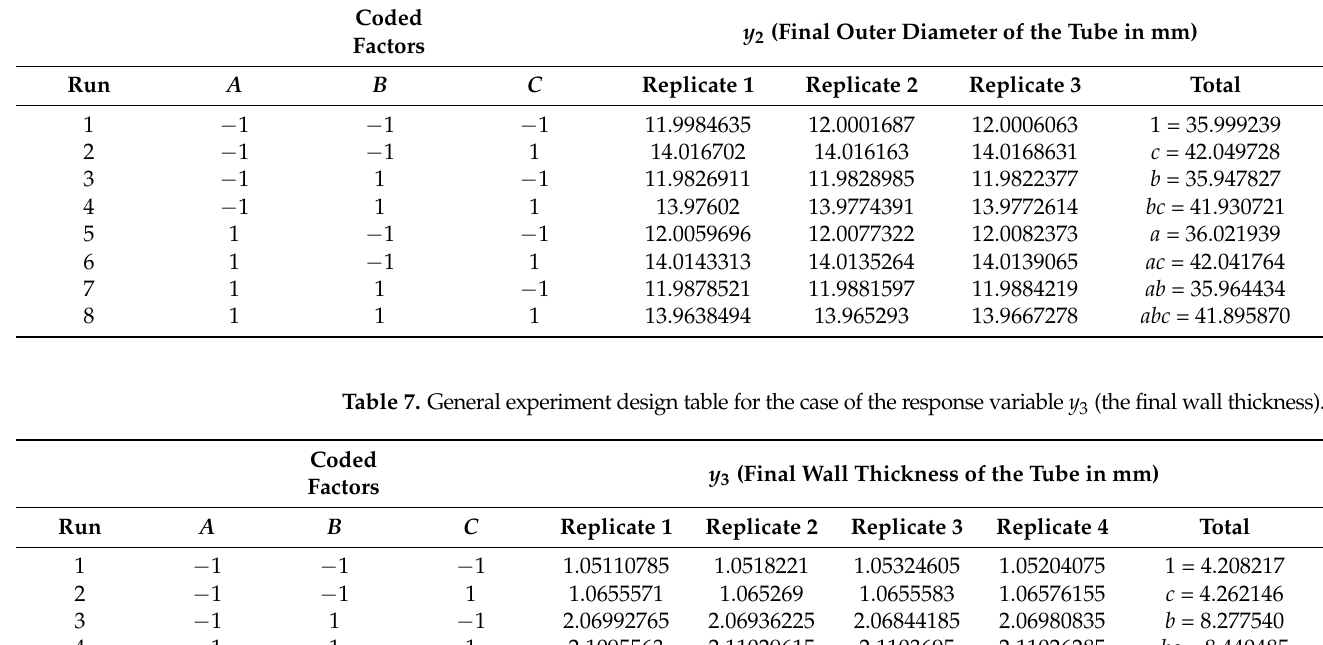
Table 6. General experiment design table for the case of the response variable y 2 (final outer diameter of the tube).